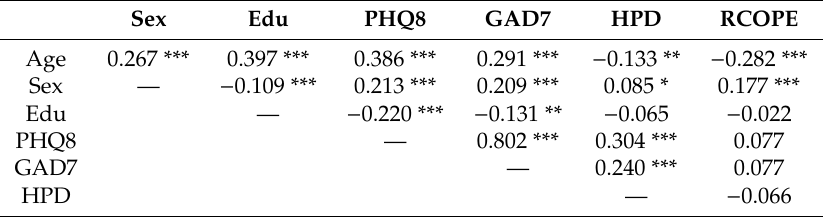
Table 3. Correlations between the study’s key variables for all